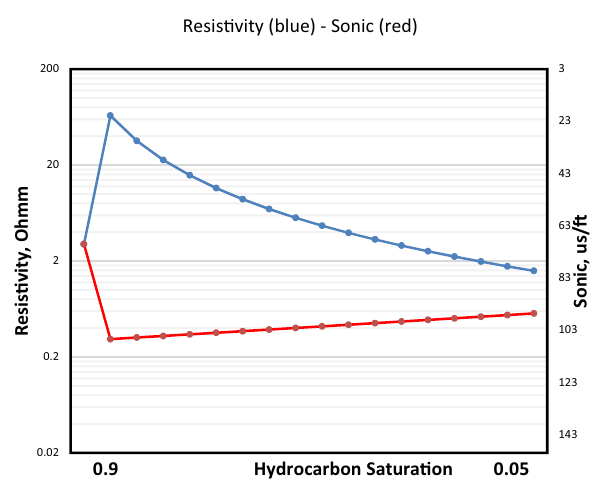
Fig. 11 Sonic–resistivity overlay, clay = 25%, m = 2